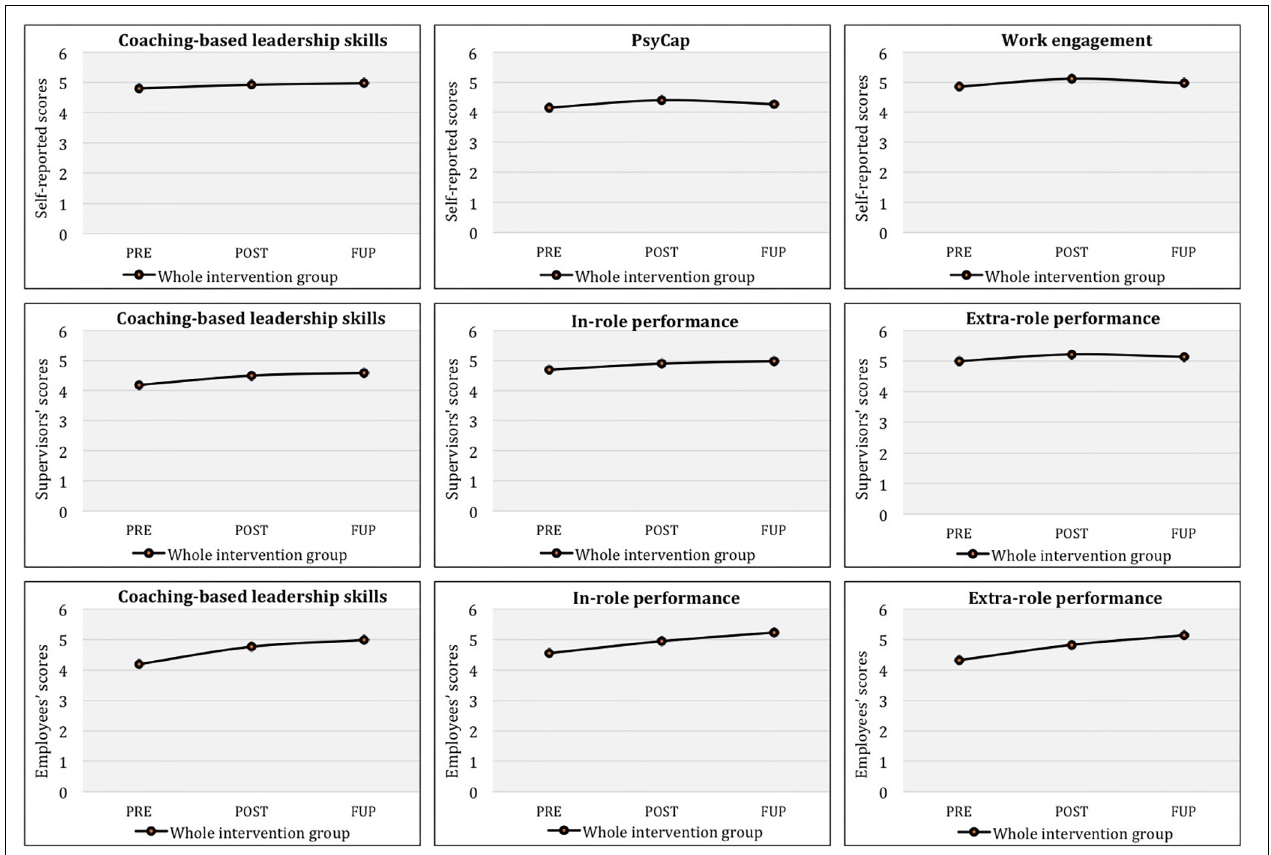
FIGURE 6 | Coaching-based leadership skills, PsyCap, work engagement, in-role and extra-role performance for the whole intervention group across